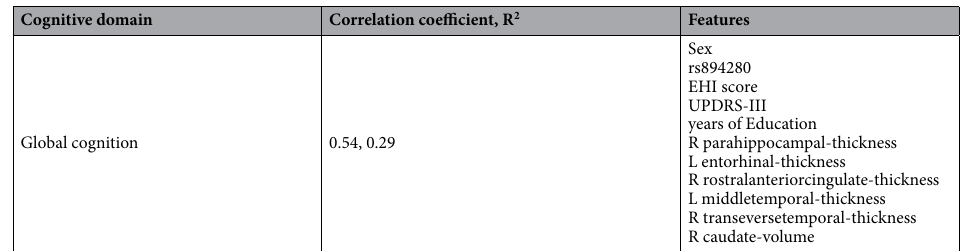
Table 2. Machine learning analysis results. Features are presented in the right column based on their importance in the machine learning model. The features are presented in a descending order (the most important to the least important). Abbreviations: UPDRS-III = Unified Parkinson’s disease Rating Scale part III, EHI = Edinburg Handedness Inventory.